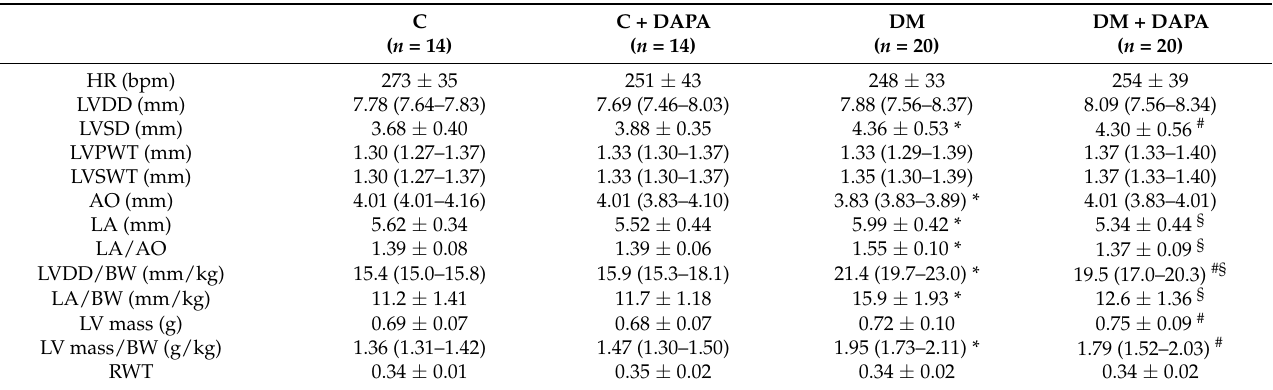
treated with dapagliflozin. Table 2. Echocardiographic structural